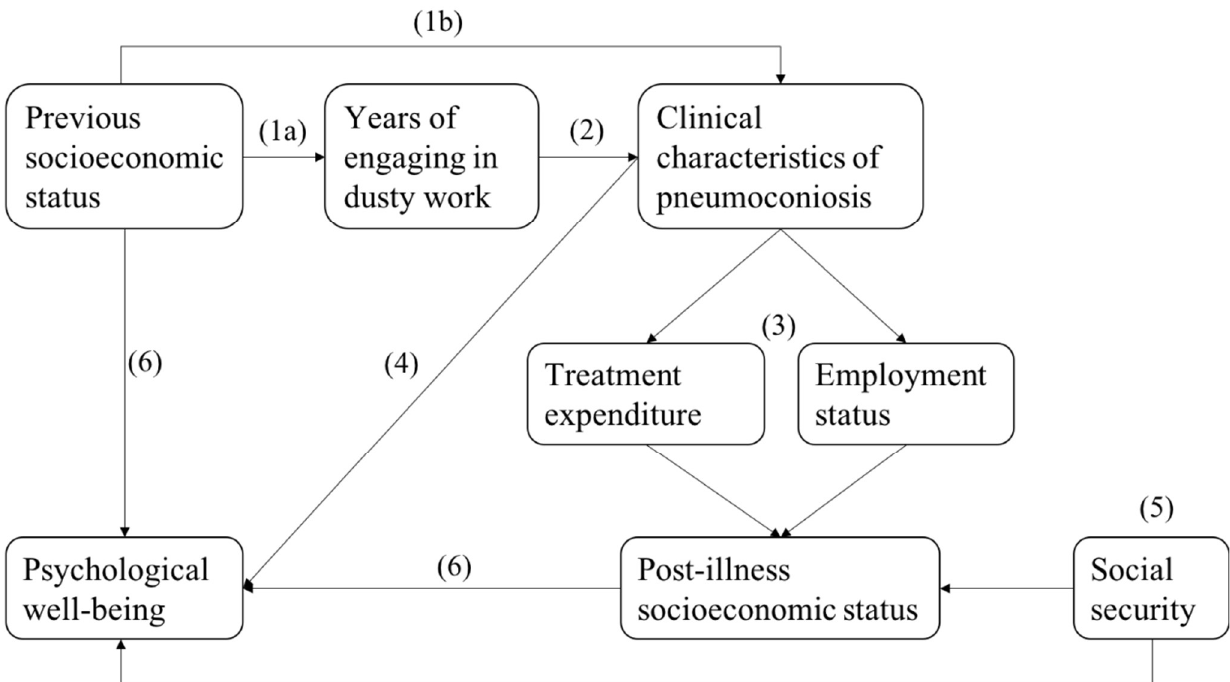
Figure 1. Research Framework of the Direct Links among the Examined Variables.